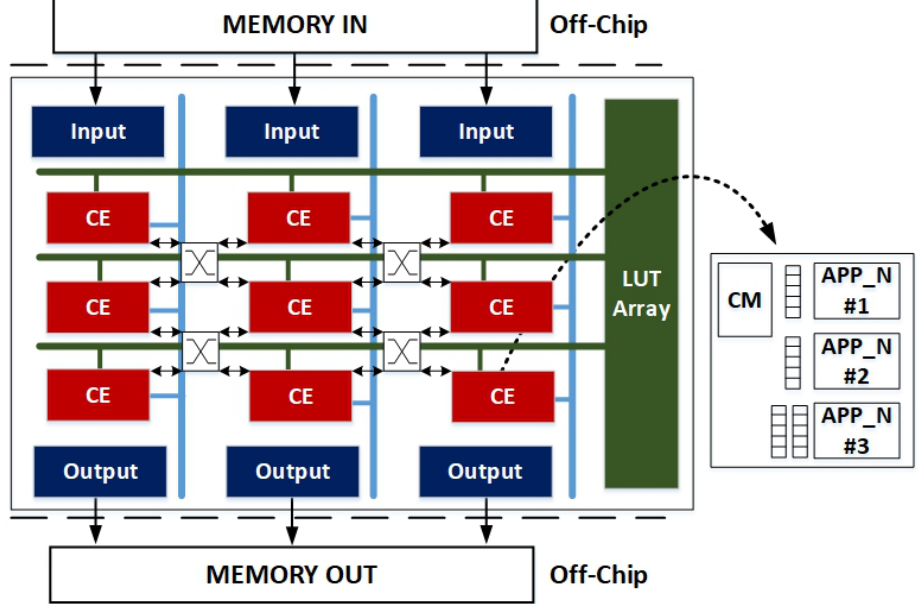
Figure 5. Structure of the proposed Coarse Grain Reconfigurable Arrays